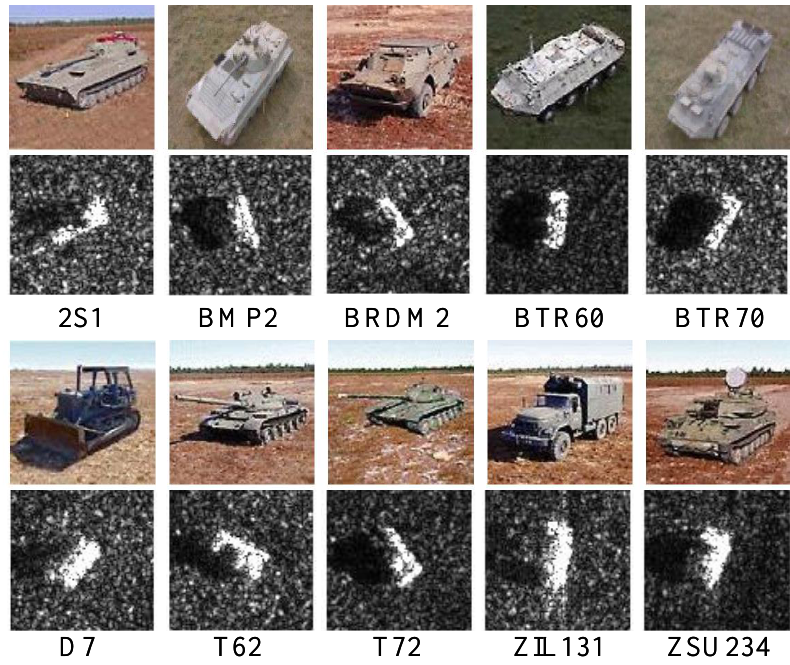
Figure 8. Optical images and corresponding SAR images of vehicles in the MSTAR